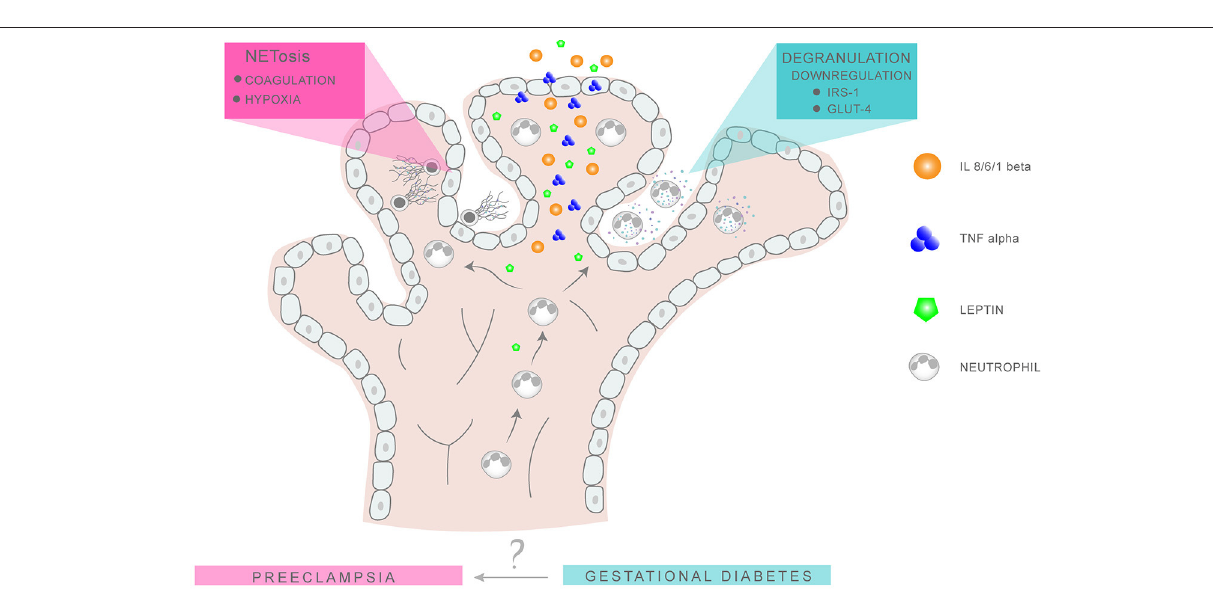
In the context of this review it is interesting to note that pronounced in eoPE than loPE cases (111). Akin to GDM,